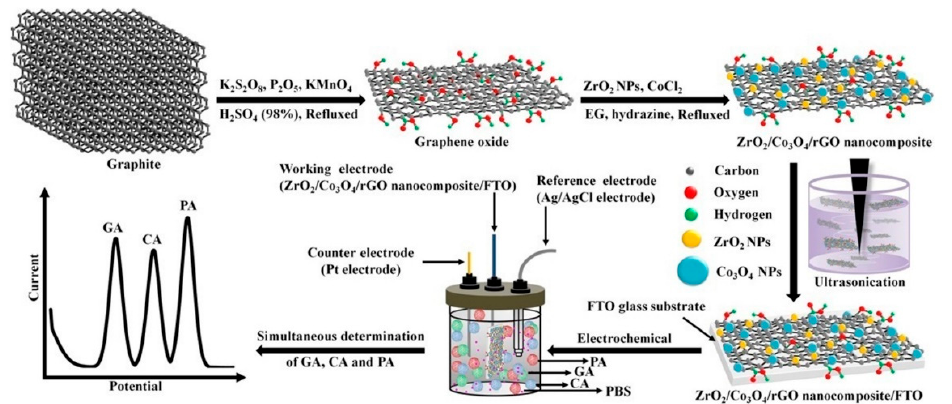
Figure 7. Fabrication of the ZrO 2 /Co 3 O 4 /rGO nanocomposite/fluorine-doped tin oxide (FTO) and scheme of the electrochemical apparatus for simultaneous detection of gallic acid, caffeic acid, and protocatechuic acid. Reprinted from ref. [39] with permission of Elsevier.